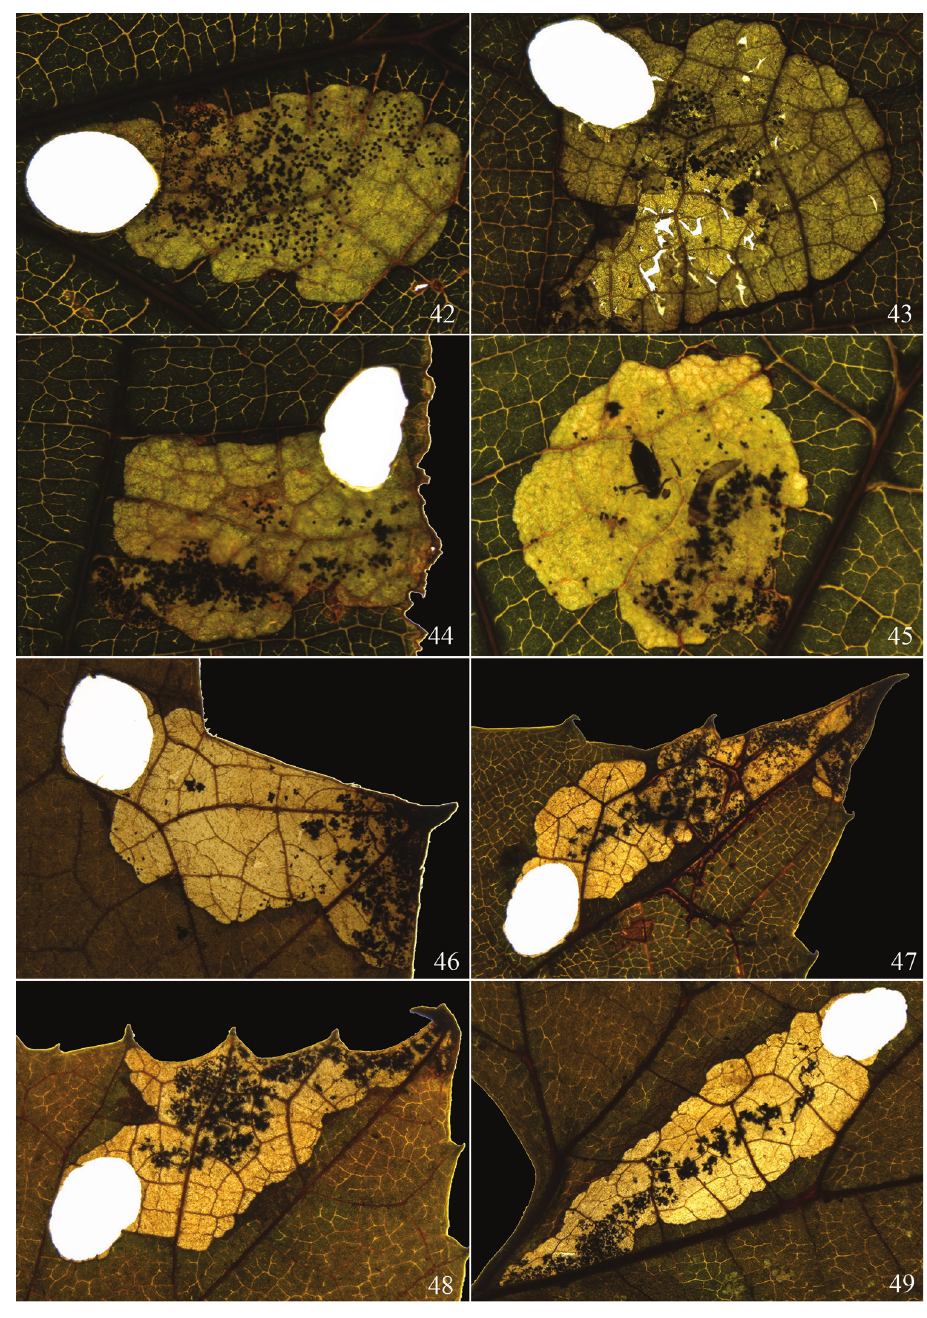
Fig. 37, one dead larva and a parasitoid, most likely a species of Eulophidae in Figure 45 46–49 A. uenoi , leaf-mines occupying leaf serration and apical area in Figures 46–48, leaf-mine occupying leaf basal area in Figure